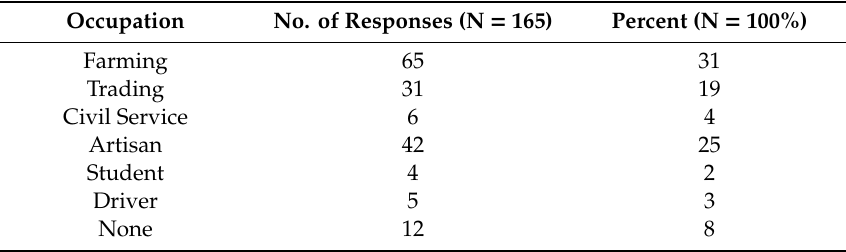
Table 2. Primary occupation of